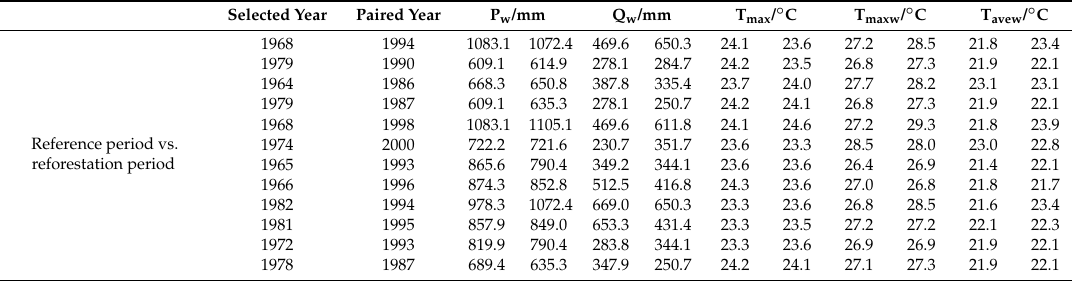
Table A3. Climate and flow variables of paired years in the Jiujushui